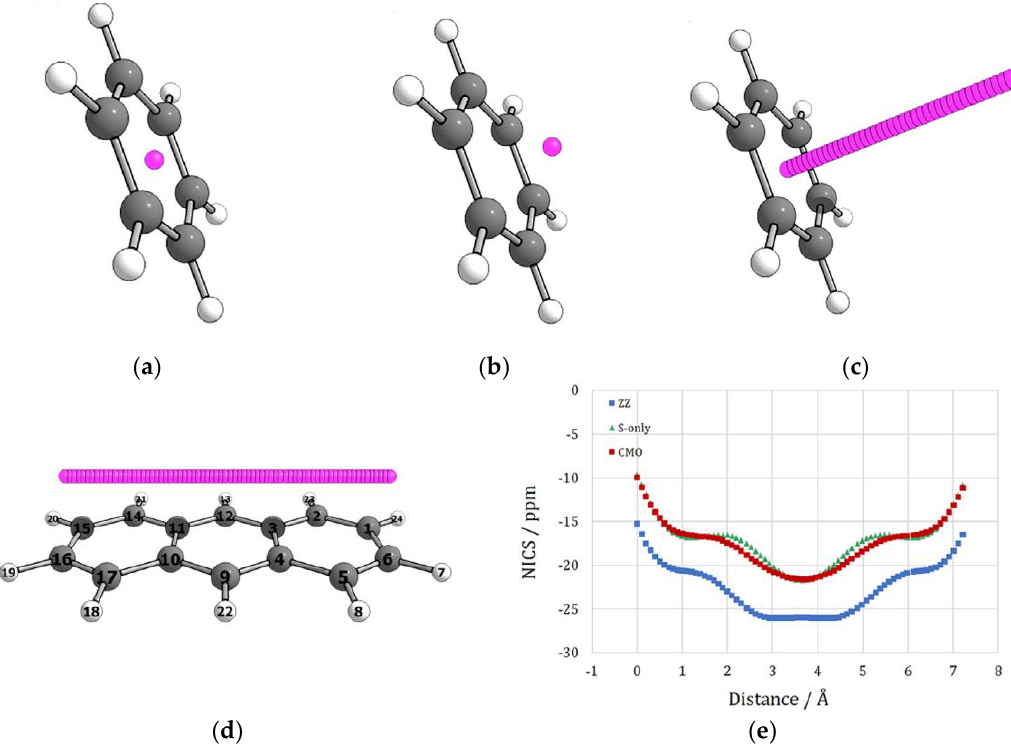
Figure 7. Examples of NICS probe locations and scan results. Benzene: ( a ) NICS(0), ( b ) NICS(1), ( c ) NICS scan along the z coordinate. Anthracene: ( d ) NICS scan along the x – y coordinate and ( e ) scan results: NICS(1.7)zz (blue) and two models eliminating σ -electron contribution to shielding: NICS σ only model (green) and canonical molecular orbitals NICS (red). Adapted from Ref. [93]. Copyright (2021), with permission from Elsevier.